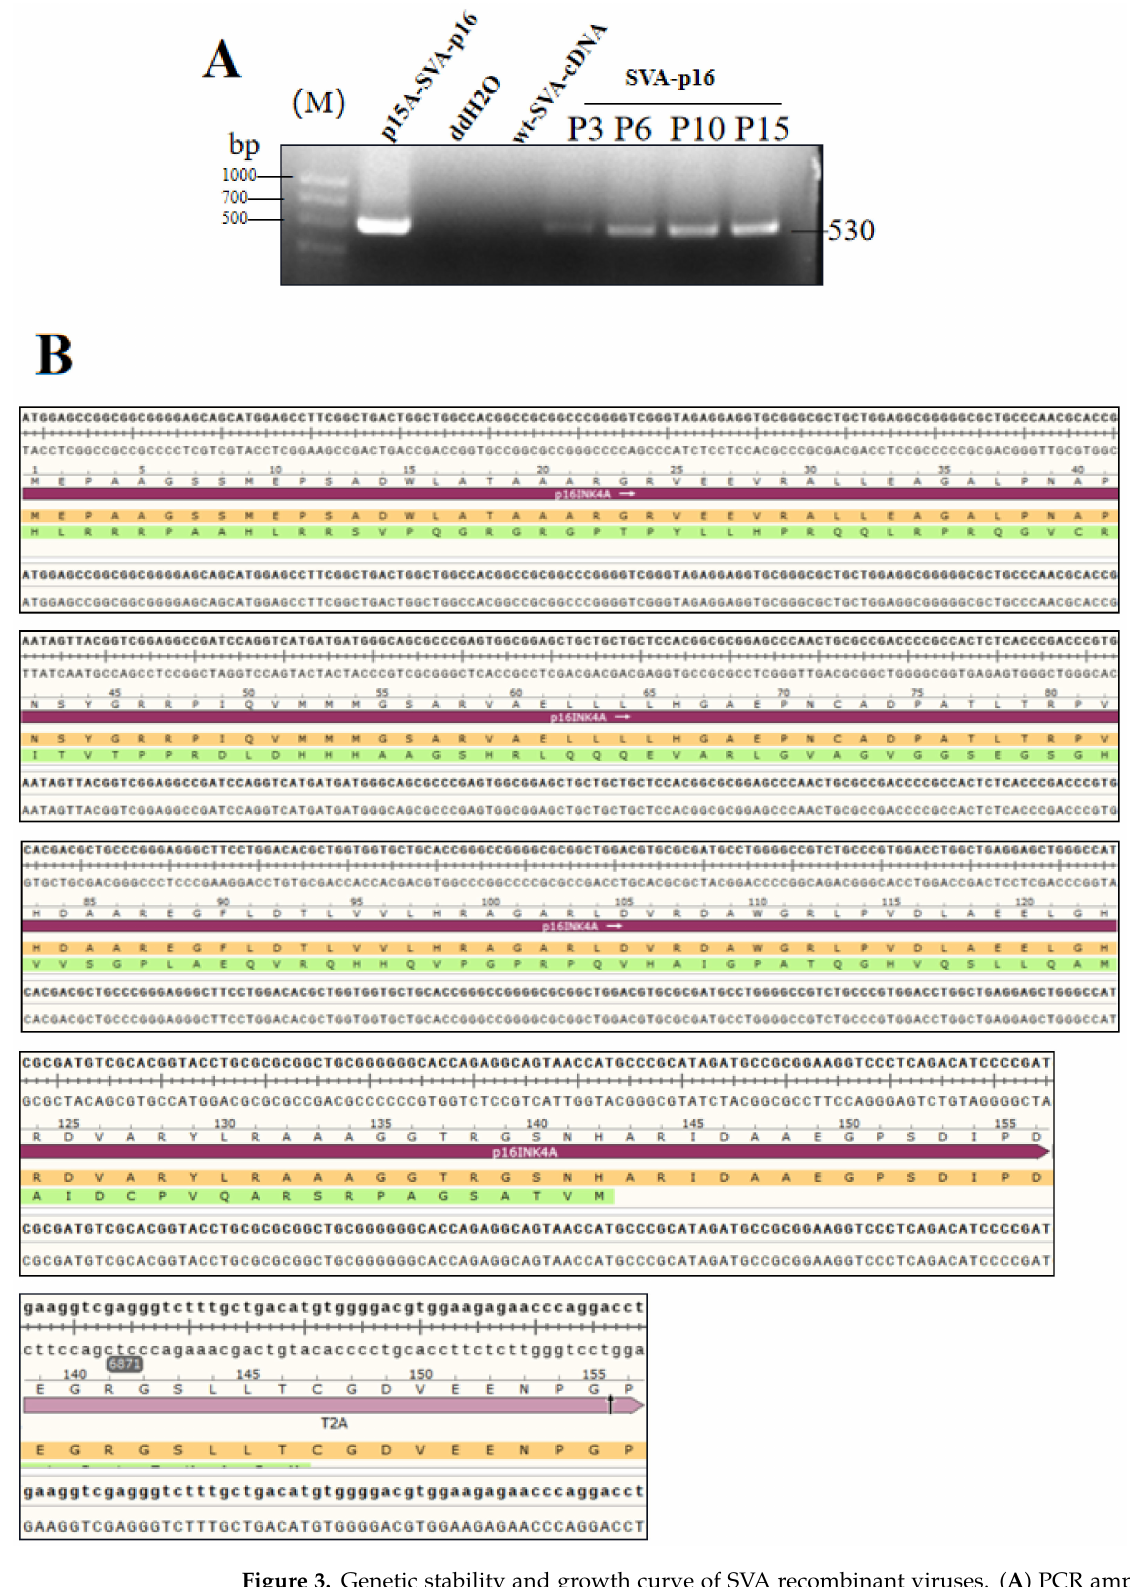
Figure 3. Genetic stability and growth curve of SVA recombinant viruses. ( A ) PCR amplification of the p16 gene in the SVA-P16 of P3, P6, P10, and P15 virus stocks with the p15A-SVA-p16 and wild-type SVA as controls. ( B ) Sequencing analysis of the p16 and